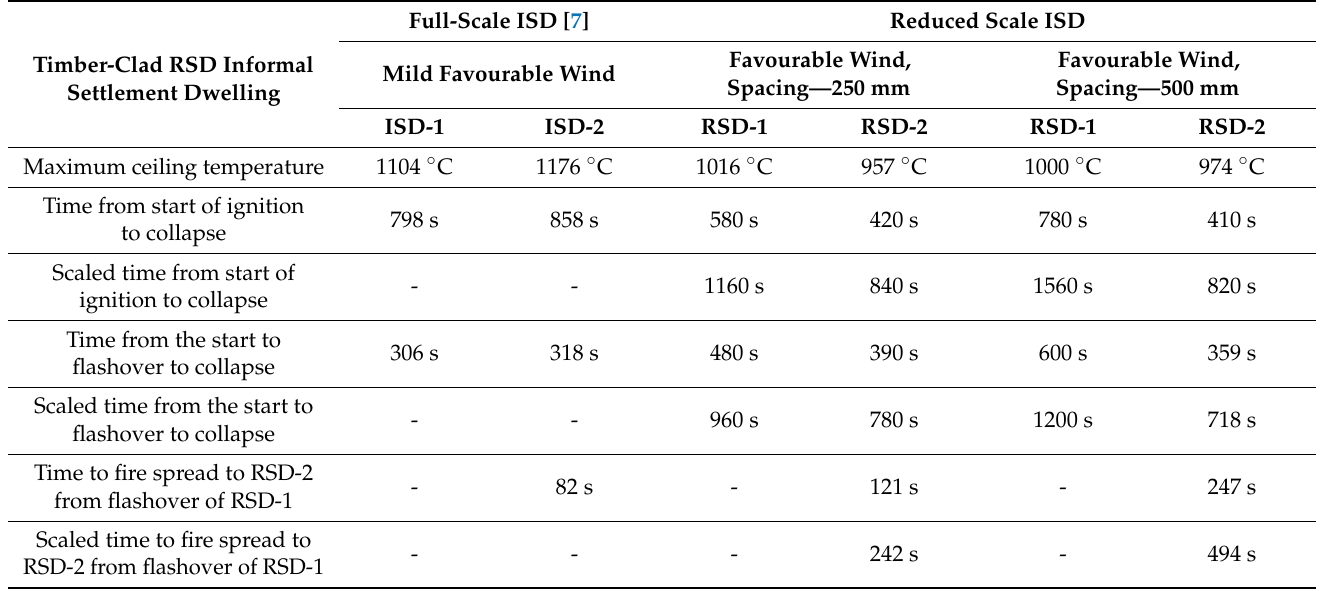
Table 6. Results from fire spread between timber-clad dwelling in full scale experiment and reduced scale